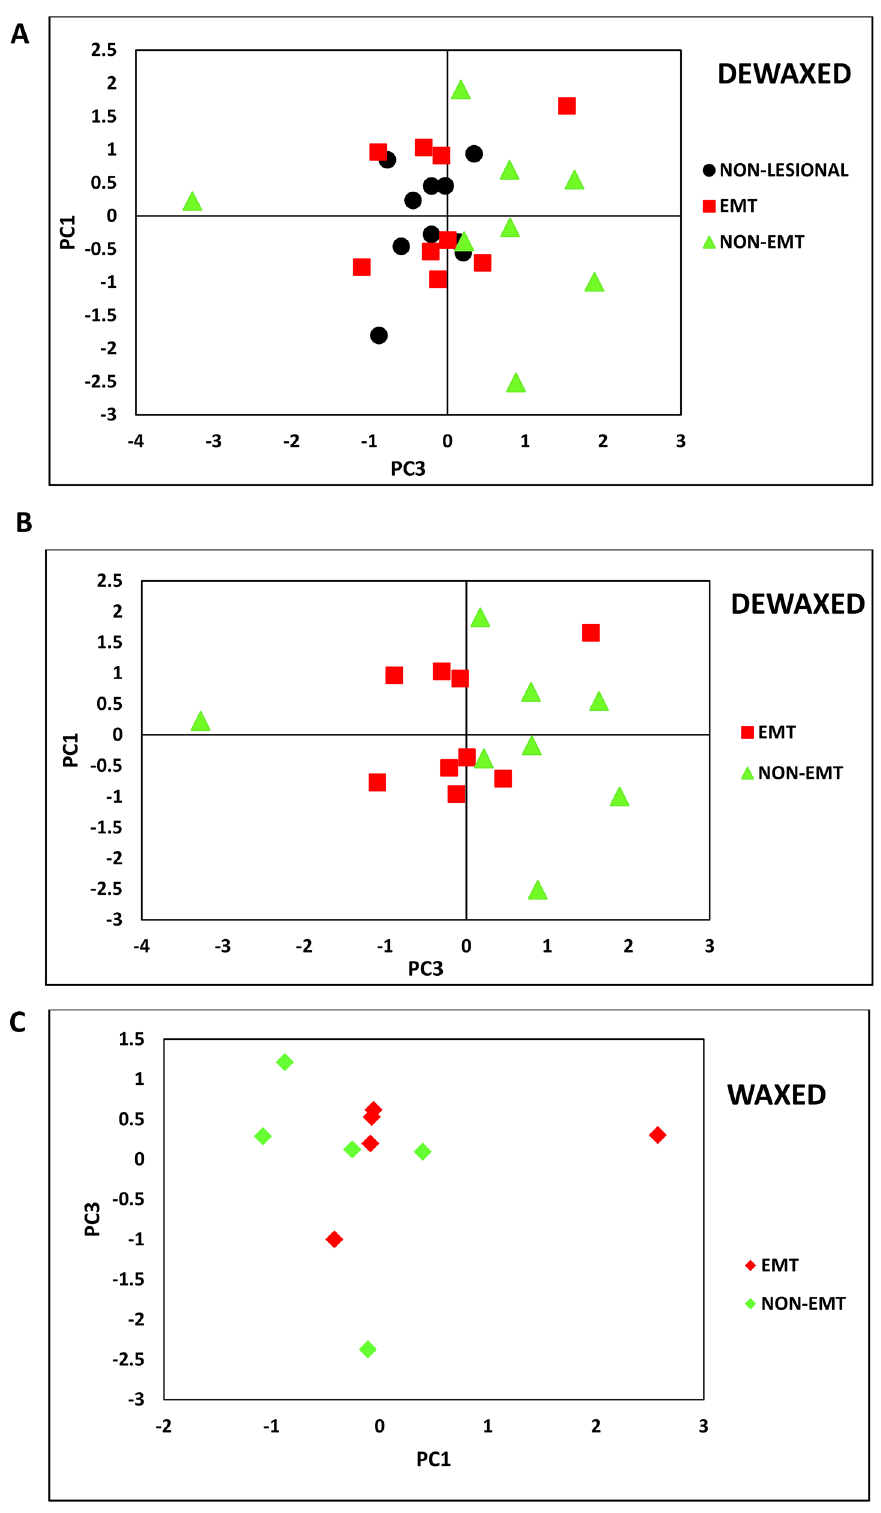
Figure 10. PCA plots of all studied samples; non-lesional, EMT and non-EMT breast tissues of both dewaxed ( A and B ) and waxed ( C )